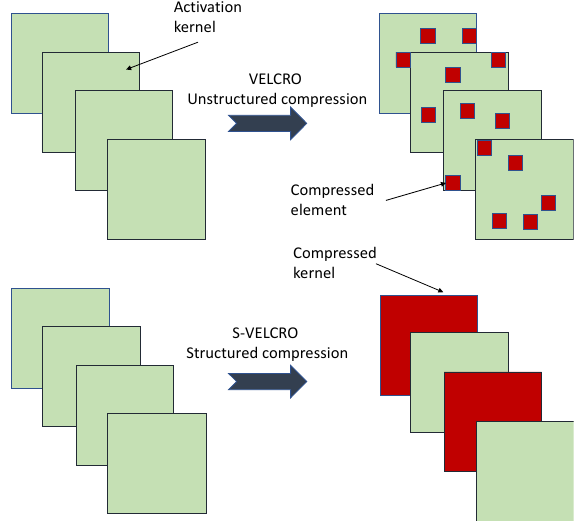
Figure 2. Structured compression versus unstructured